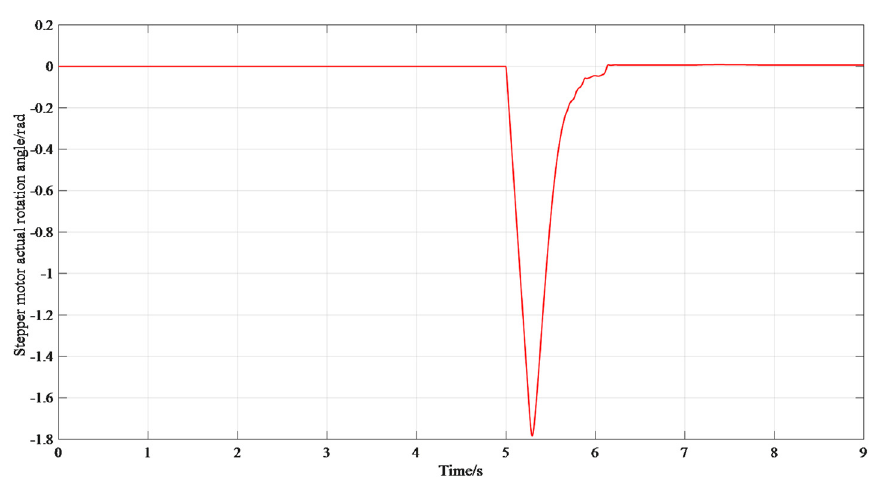
Figure 14. Response effect of incremental PID-based automatic control system of cutter height off the ground when the harvester suddenly climbs a slope.